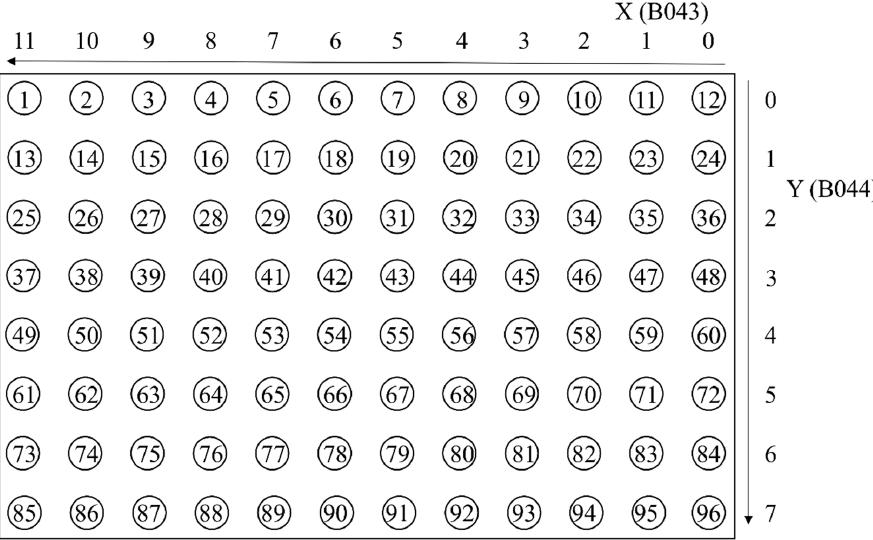
Figure 5. Arrangement of 96 pipette tips on a tip box and the related labels.